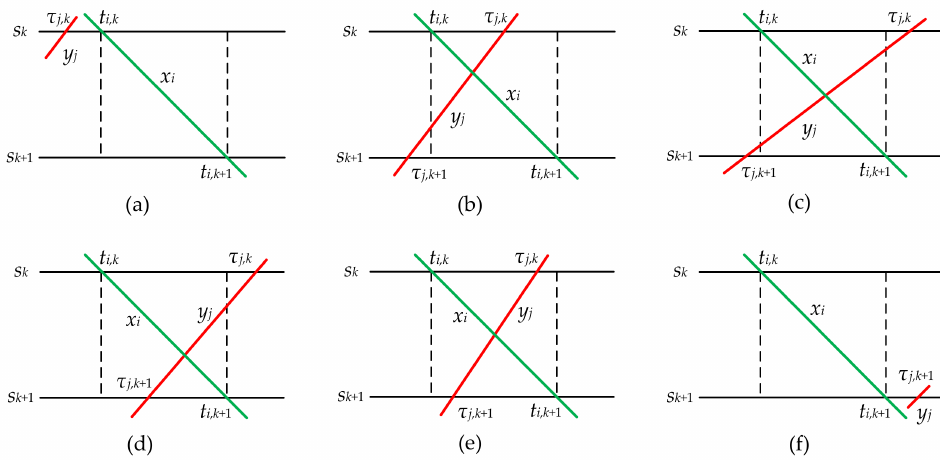
Figure 6. The train diagram of x i and y j in ( t i , k , t i , k+ 1